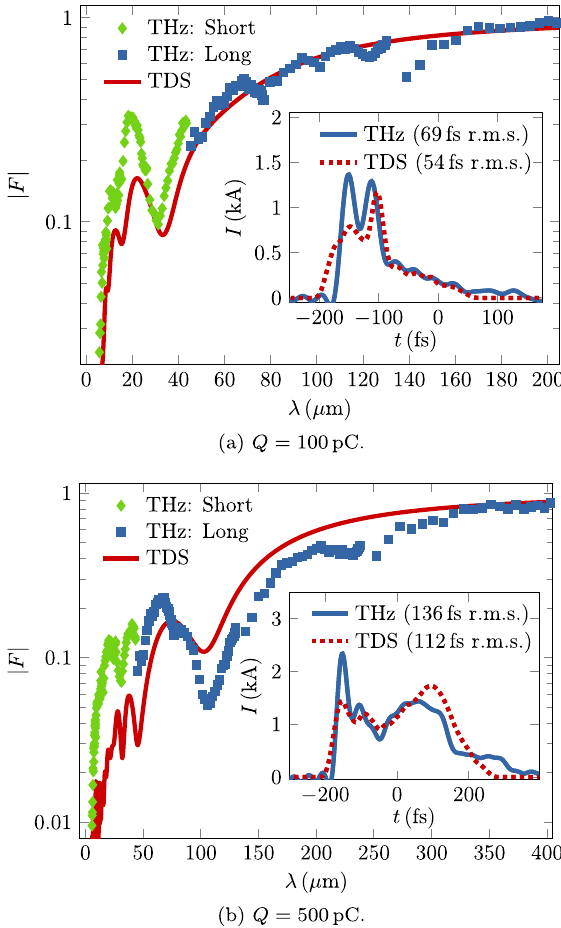
FIG. 6. Mean moduli of the longitudinal form factors mea- sured by THz spectroscopy of coherent transition radiation (green diamonds and blue squares) and derived from TDS measurements (solid red lines), generated by electron bunches with charges of (a) 100 pC and (b) 500 pC, respectively. The insets show single-shot electron bunch currents reconstructed from THz spectra (solid blue lines) in comparison with single- shot TDS measurements (dotted red lines), and the numbers in the brackets represent the calculated rms bunch